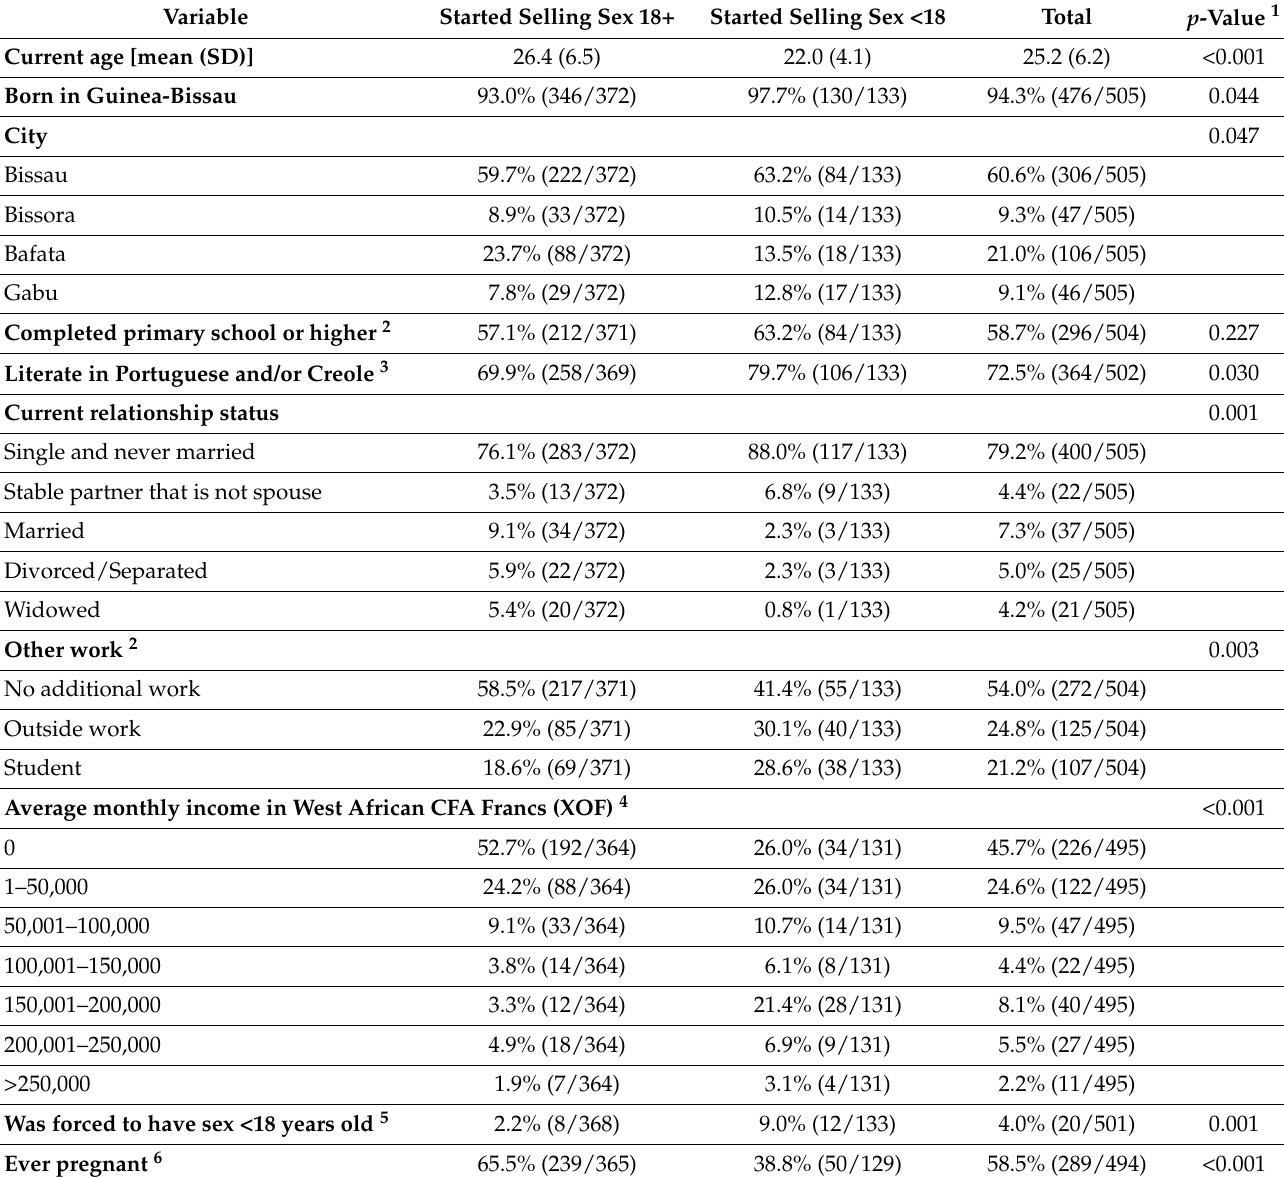
Table 1. Characteristics of female sex worker study participants (n = 505) in Guinea-Bissau by early or later initiation of selling sex,